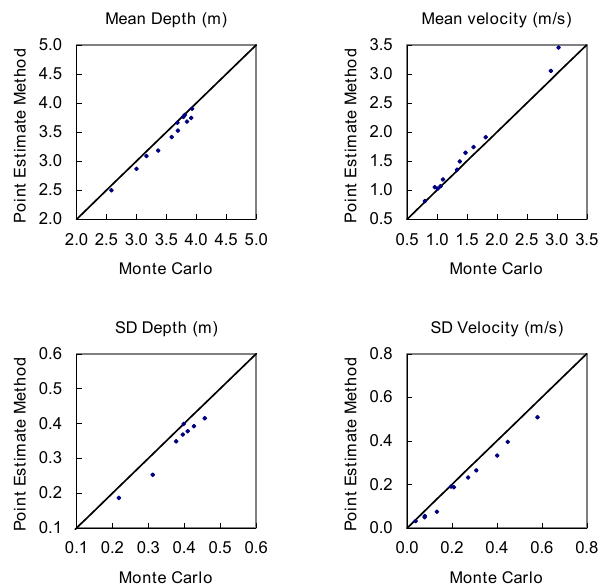
Fig. 9. 1-D HEC-RAS model. Mean and standard deviations of wa- ter depth and velocity predicted by point-estimate method against Monte Carlo. Results for n i uniformly distributed and flow case 300m 3 s − 1 . Each dot corresponds to a different RS of the model.